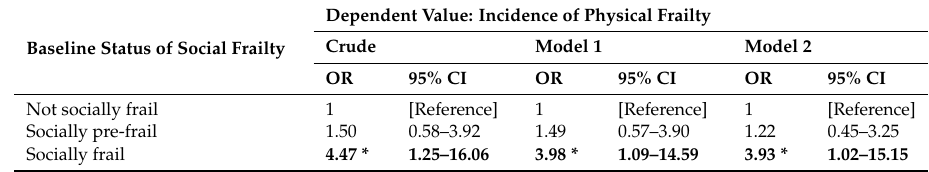
Table 2. Odds ratios for the development of physical frailty after four years, with reference to baseline social frailty status among older adults without physical frailty.